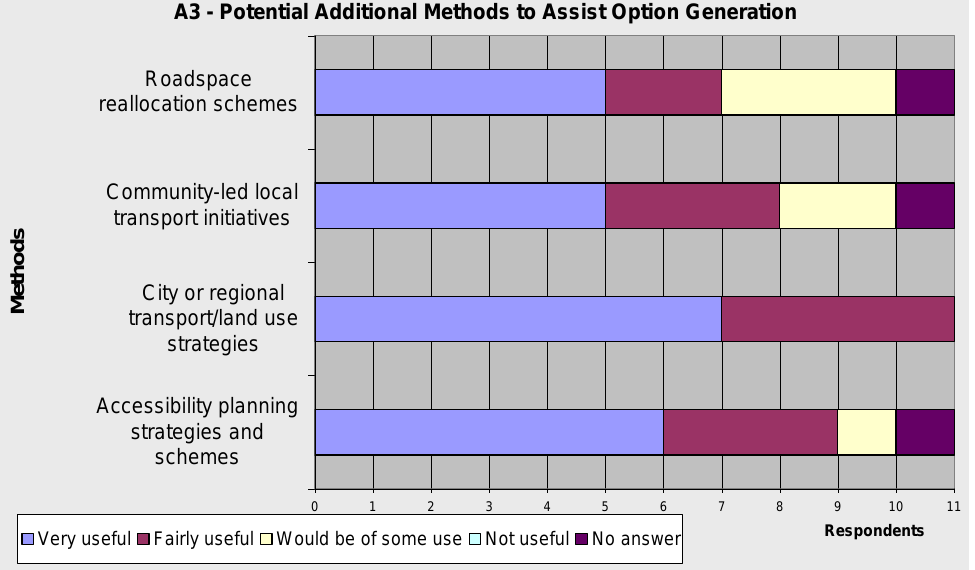
Figure 1. Perceived usefulness of new tools in areas selected by DISTILLATE Source: Hull and Thanos, 2008, response to Qu.